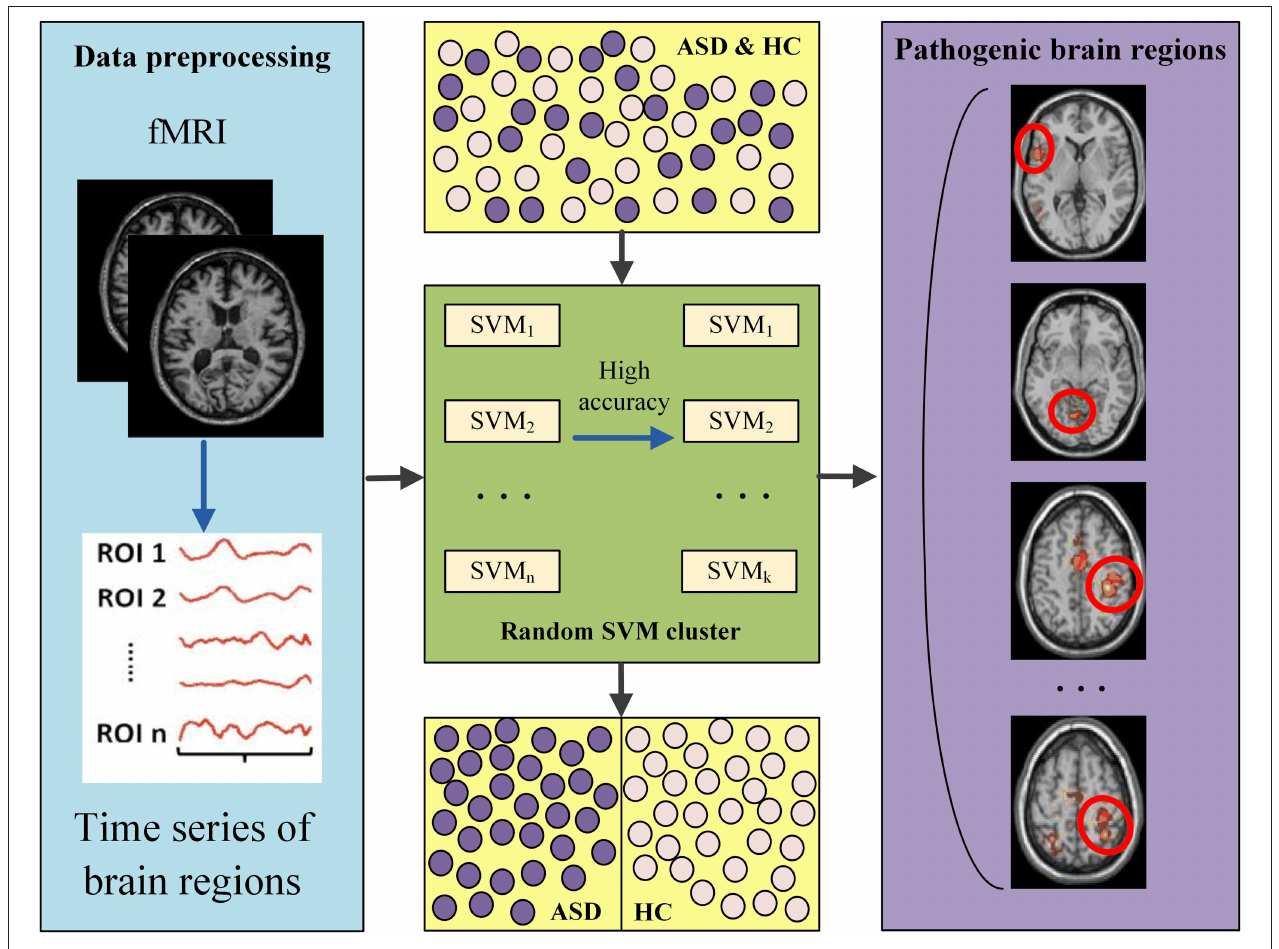
FIGURE 1 | The entire workflow of this study.